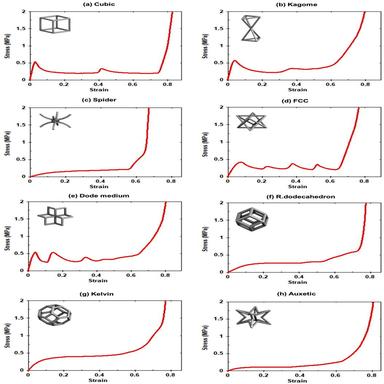
Stress-strain relationships of set 2 structures: a) cubic, b) kagome, and c) spider, d) FCC, e) dode medium, f) rhombic-dodecahedron, g) auxetic, and h) kelvin.